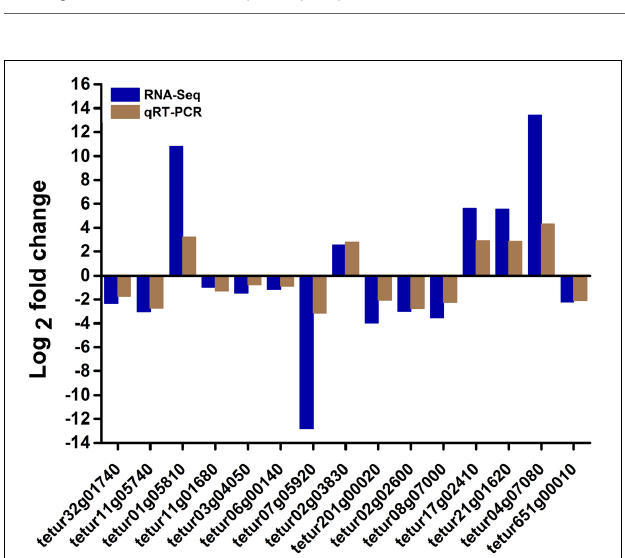
FIGURE 5 | RT-qPCR validation of some differentially expressed genes in RNA-seq. The relative expression levels of fifteen differentially expressed genes in scopoletin- or solvent-treated T. cinnabarinus were determined by RT-qPCR. RPS18 was used as the reference gene to normalize the gene expression using the (cid:49)(cid:49) Cq method. The y-axis indicates the log 2 fold change of each gene in RT-qPCR and RNA-seq.